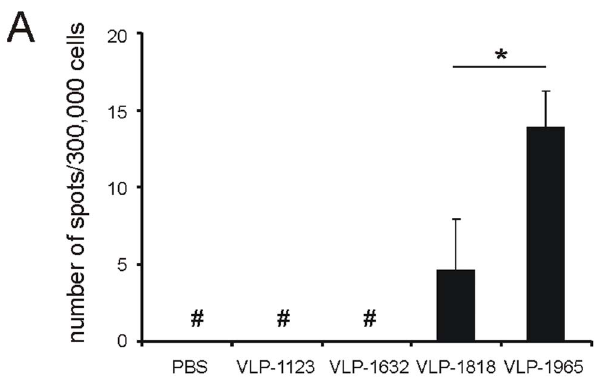
Figure 3. VLPs with nucleic acids promote a Th1-polarized cellular immune response. BALB/c mice (n=23 per group) were immunized twice by i.p. injection of 10 m g of VLP-1123, VLP-1623, VLP- 1818 or VLP-1965 formulated with Alhydrogel. An additional control group received PBS with Alhydrogel (PBS). Priming and boosting injections were two weeks apart. Two weeks after the boost, splenocytes were isolated from five mice in each group and analyzed in triplicate for each mouse. Following 16 h of in vitro stimulation of splenocytes with M2e peptide, IFN- c secreting cells were quantified by ELISPOT analysis. Results are shown as the average number of spots per 300,000 splenocytes. Bars represent averages with error bars depicting the standard error of the mean (*: P , 0.001 two-sample t-test). # : less than 10 spots.